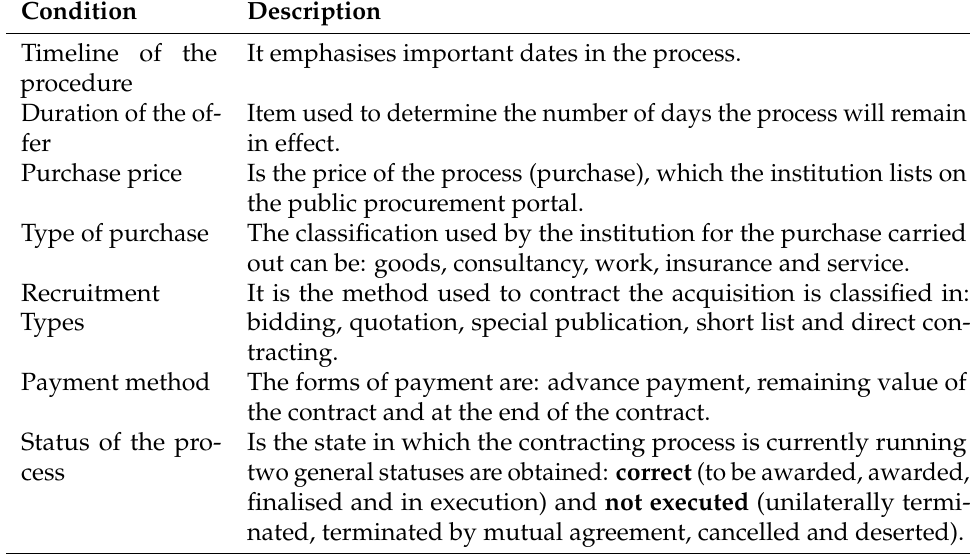
Table 1. Conditions considered of each